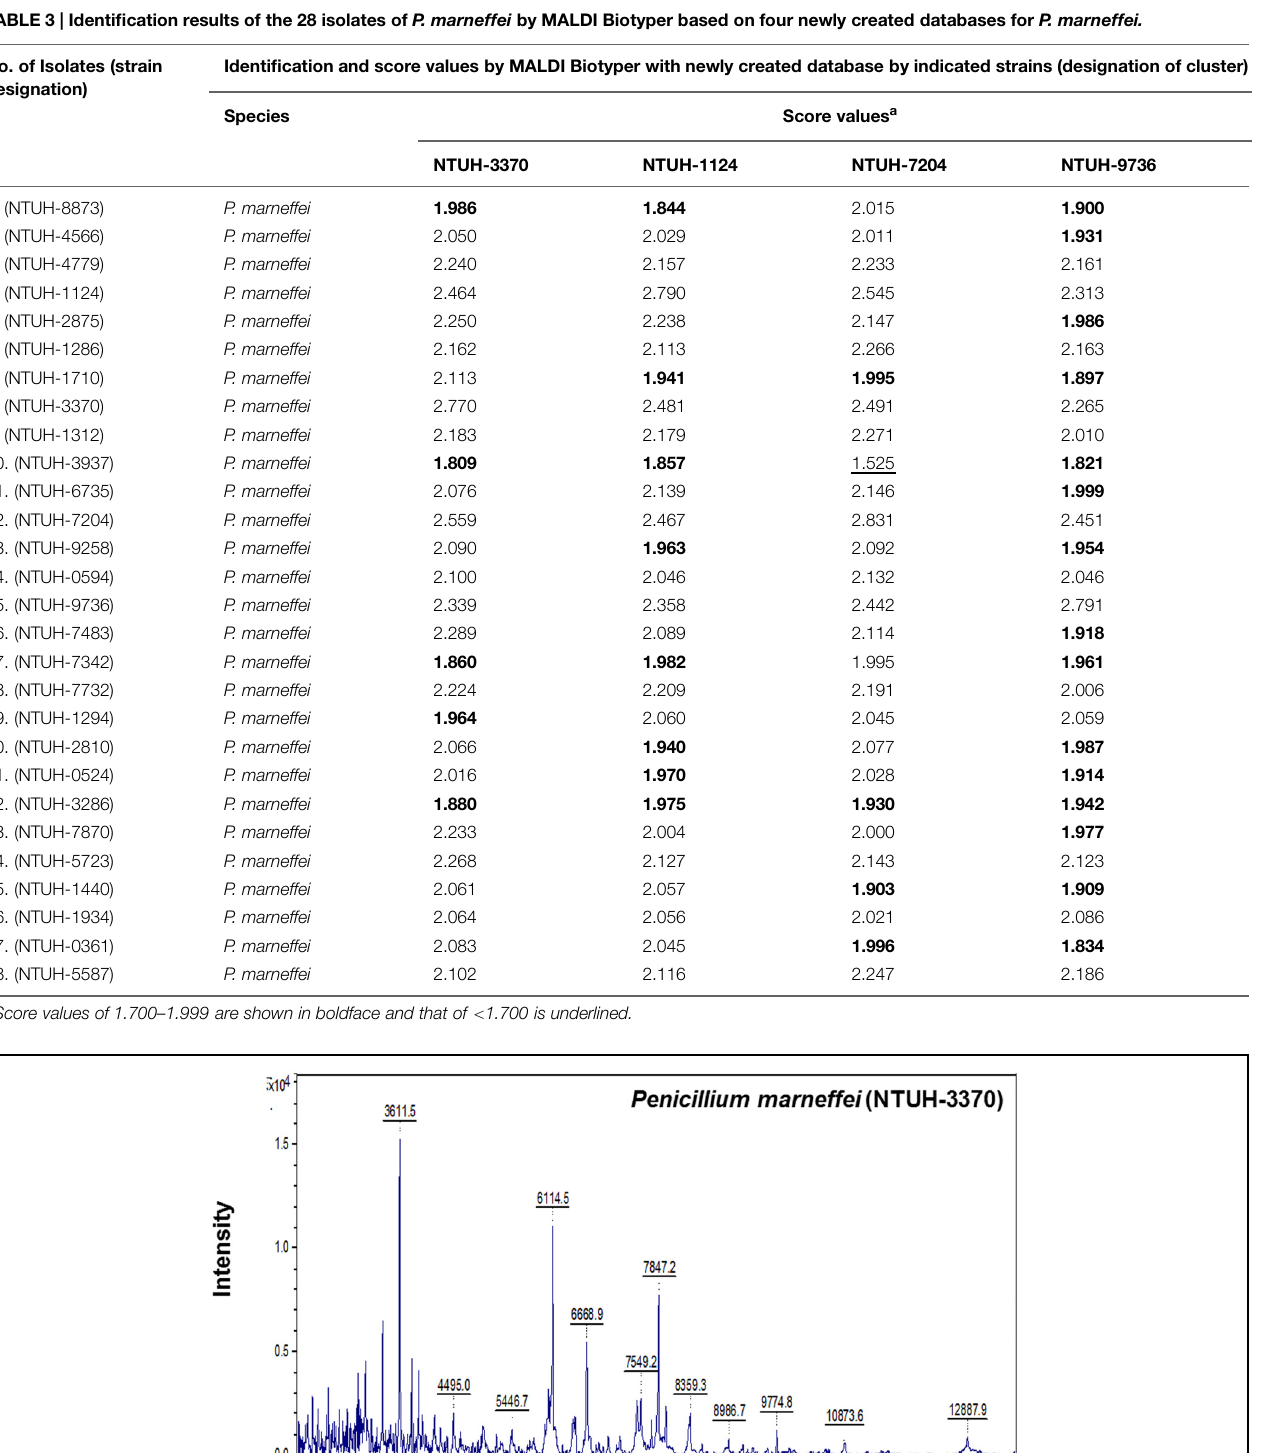
Frontiers in Microbiology |